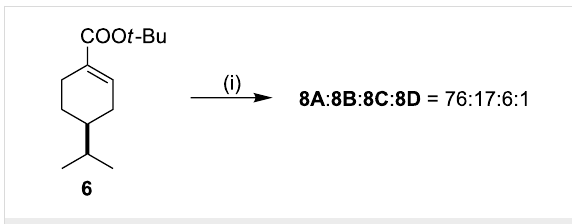
Scheme 3: Reagents and conditions: (i) 2.4 equiv LiNBn 2 , dry THF, − 78 °C, 6 h, then NH 4 Cl (aq), overall yield: 85% (isomeric mixture).